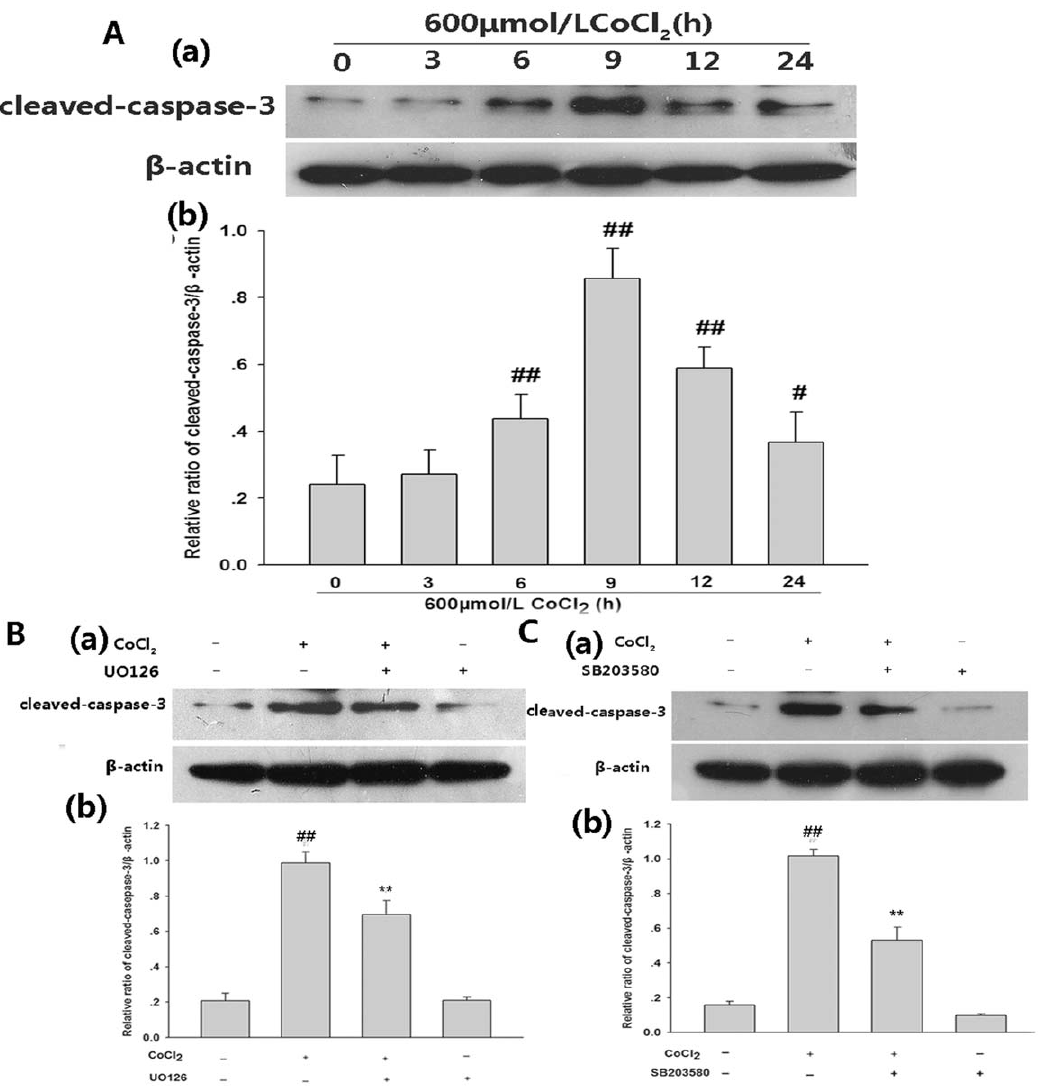
Figure 9. Kinase inhibitors suppressed CoCl 2 -induced expression of cleaved-caspase-3. (A) time course for the effects of CoCl 2 on expression of cleaved-casepase-3. (A-b) Denstiometric analysis for the results in (A-a). Data are presented as the mean 6 SD from independent experiments performed in triplicate. # P , 0.05, ## P , 0.01 compared to the control group. (B) and (C) PC12 cells were preconditioned with 10 m mol/L MEK1/2 (upstream of ERK1/2) inhibitor U0126 for 120 min (B) and 20 m mol/L p38MAPK inhibitor SB203580 for 60 min (C) before exposure of cells to 600 m mol/L CoCl 2 for 9 h. Panels B-b and C-b show denstiometric analysis for the data from B-a or C-a, respectively. Data are presented as mean 6 SE from independent experiments preformed in triplicate. ## P , 0.01 compared to the control group, ** P , 0.01 compared to the CoCl 2